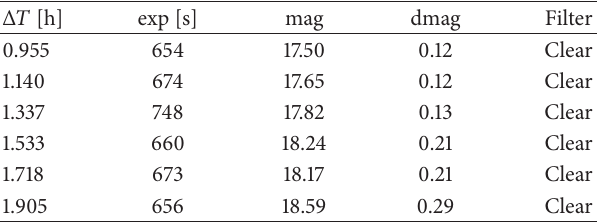
Table 13: GRB 120327A: observing log of BOOTES-1B.